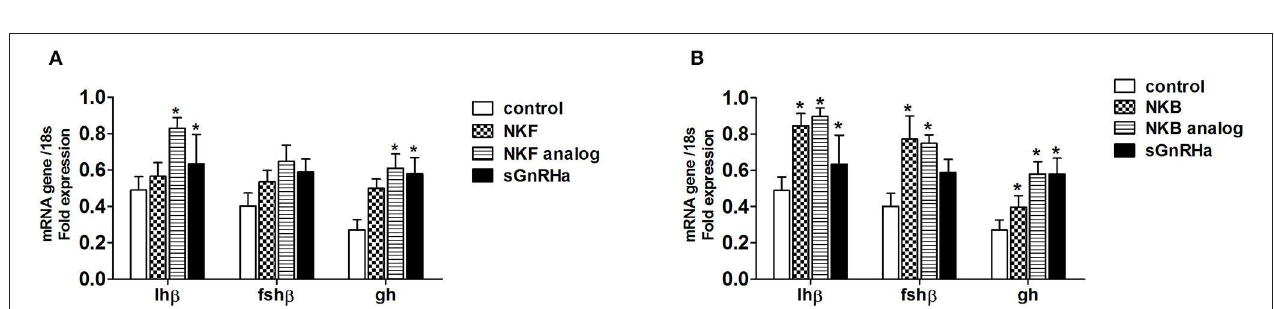
FIGURE 4 | In vivo effect of tilapia NKB or NKF and their analogs on GH (A,D) , FSH (B,E) , and LH (C,F) plasma levels. Female tilapia were injected with native NKB or NKF peptides, analogs (100 µ g/kg BW), or sGnRHa (10 µ g/kg BW) at time 0; saline-injected fish served as controls. Blood was sampled at 1, 2, 4, 8, and 24h after injection. Plasma GH, FSH, and LH values were analyzed by specific ELISA (Mean ± SEM; n = 8 fish per group). Columns marked by asterisks significantly differ from basal: * p < 0.05; ** p < 0.01 (two-way ANOVA followed by Dunnett).